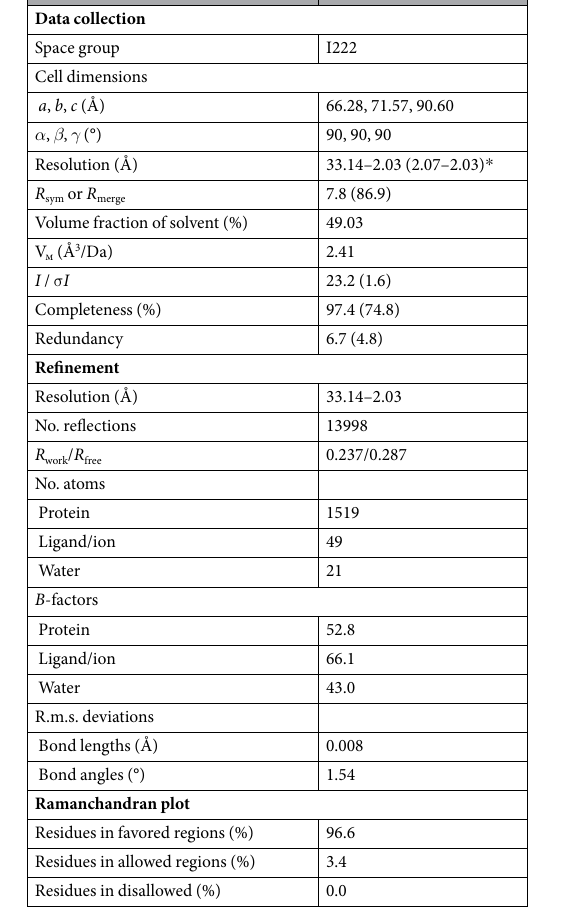
Table 1. Data collection statistics and refinement parameters for mTnfaip8. * Values in parentheses are for highest-resolution